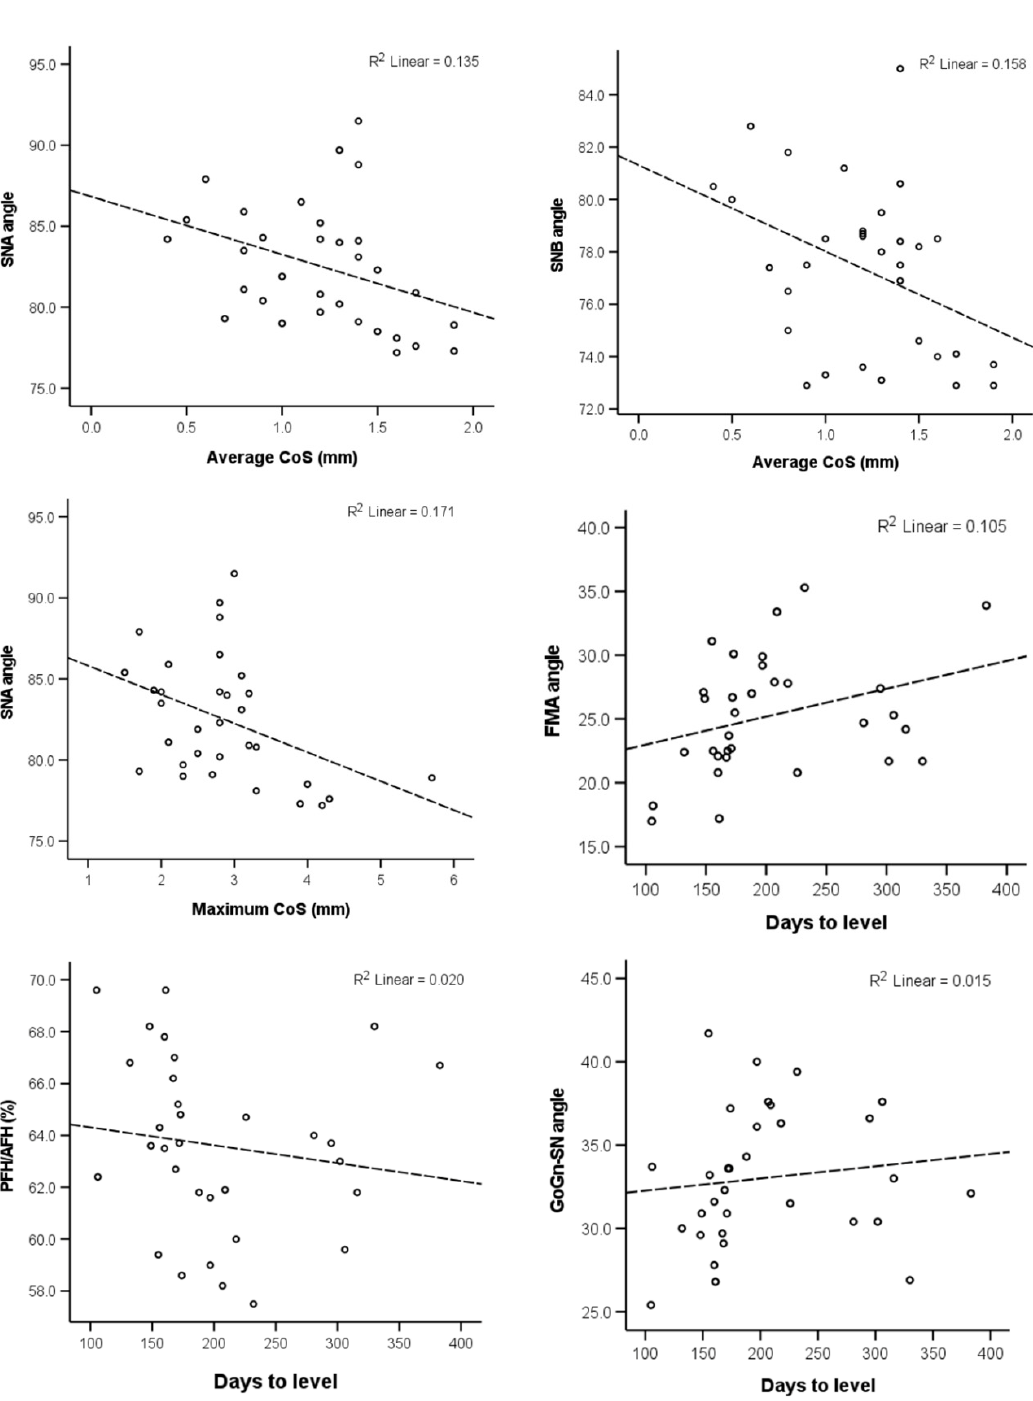
Figure 3. Scatter plots depicting the relevant data regarding the correlations reported in Table 2 and had p < 0.10. The dashed lines show the least squares linear lines that best fit the data.